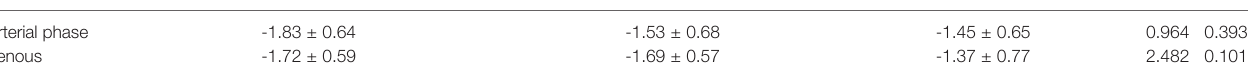
TABLE 4 | Slope analysis of spectrum curves of lesions, metastatic lymph nodes, and intravascular emboli in group 3 (stages III and IV). Slope of the energy spectrum curve of the lesion Slope of the energy spectrum curve of metastatic lymph